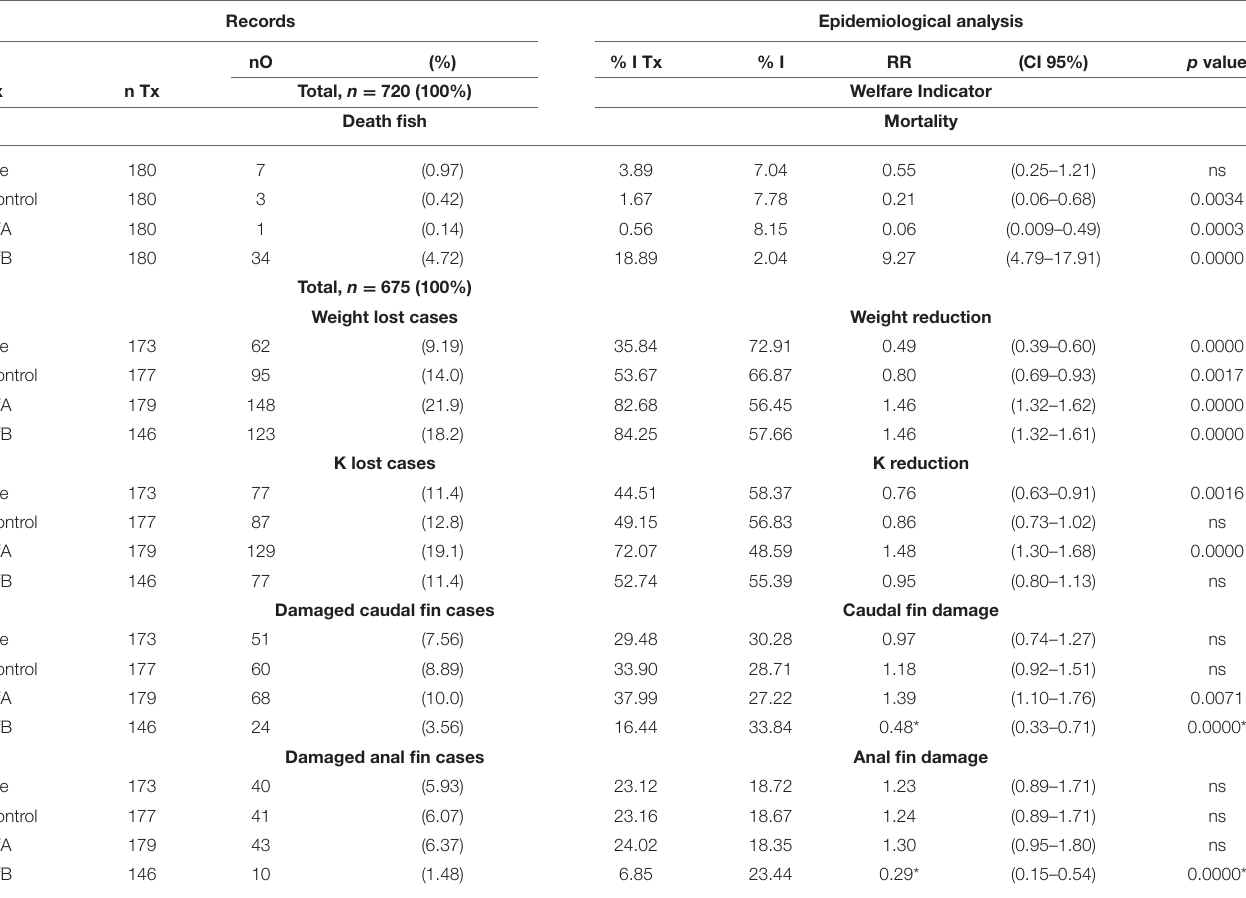
TABLE 8 | Contingency table, incidence of mortality, weight reduction, K reduction, and caudal and anal fin damage of on-growing 3 of O. niloticus according to the feeding